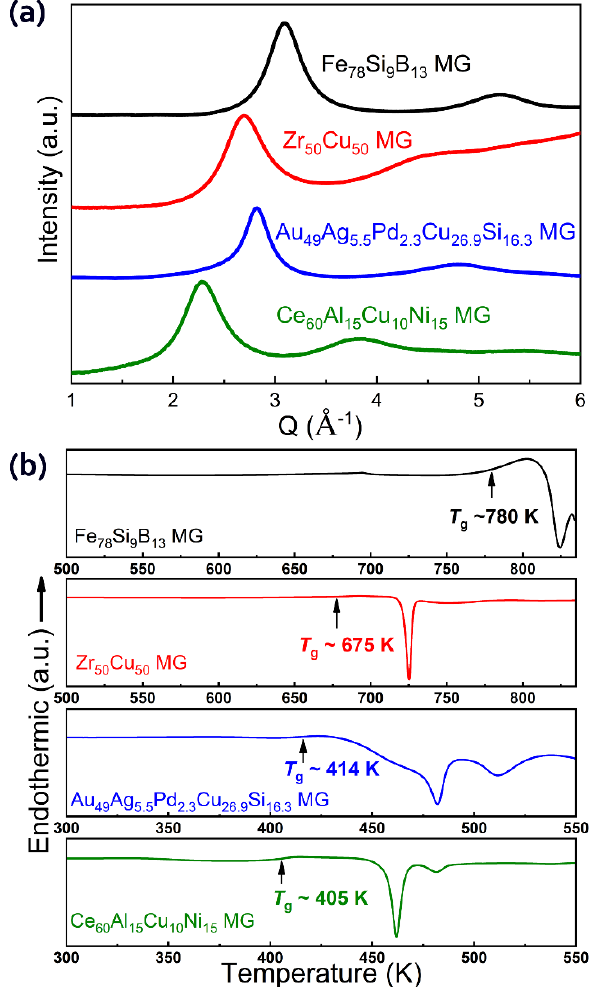
Figure 1. Characterization of the Fe 78 Si 9 B 13 , Zr 50 Cu 50 , Au 49 Ag 5.5 Pd 2.3 Cu 26.9 Si 16.3 , and Ce 60 Al 15 Cu 10 Ni 15 (nominal compositions) metallic glass samples. ( a ) Synchrotron X − ray diffraction patterns of the four metallic glasses. ( b ) Differential scanning calorimetry traces of the four metallic glasses. Table 1. Mechanical and physical parameters ( σ y, yield stress; ν , Poisson’s ratio; E , elastic modulus; H , hardness; T g , glass transition temperature) of the four metallic glasses.